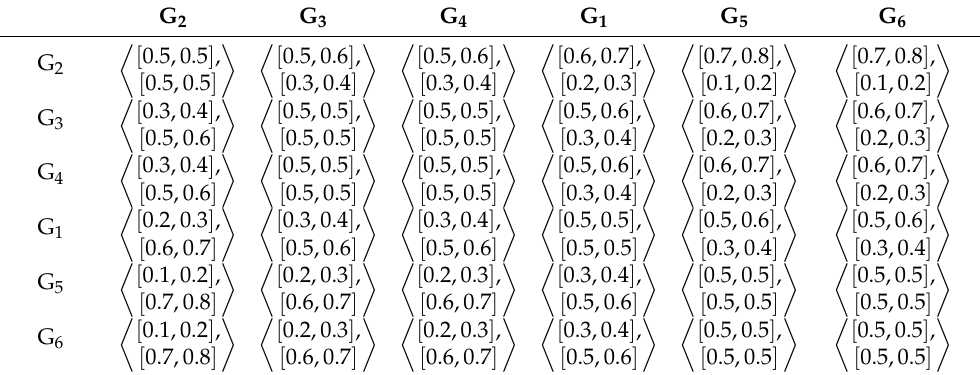
Table 11. Aggregated decision interval matrix in IVPF–AHP for the sub-criteria G (CI = 0.0312977, CR =